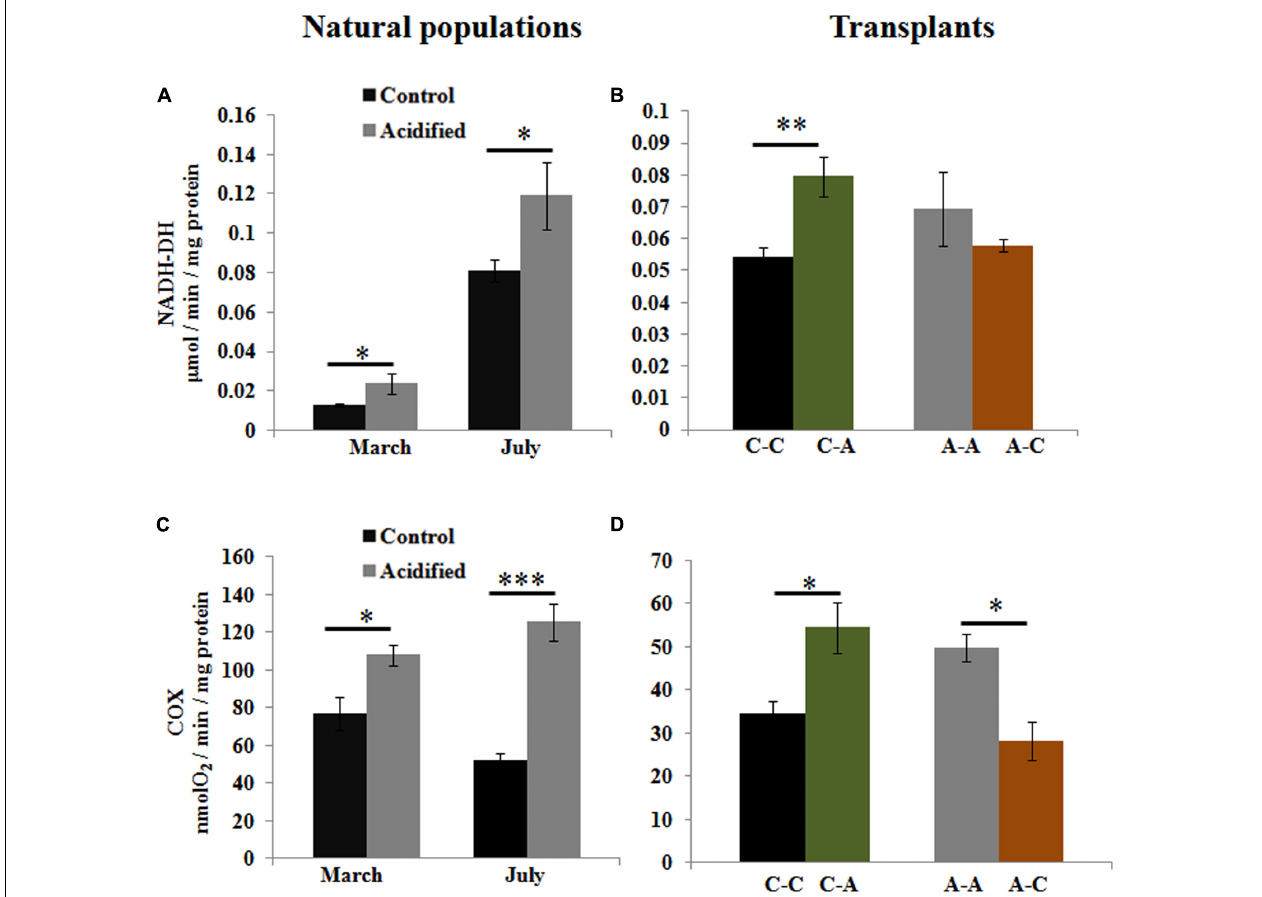
FIGURE 4 | Activities of oxidative metabolic enzymes, NADH-DH, and cytochrome c oxidase (COX), in S. vulgare samples collected at the control and the acidified site in March and July (natural populations) (A,C) and after reciprocal transplants (B,D) . C-C = control to control, C-A = control to acidified, A-A = acidified to acidified, A-C = acidified to control. Values are mean ± SE, n = 3, ∗ p < 0.05, ∗∗ p < 0.01, ∗∗∗ p <